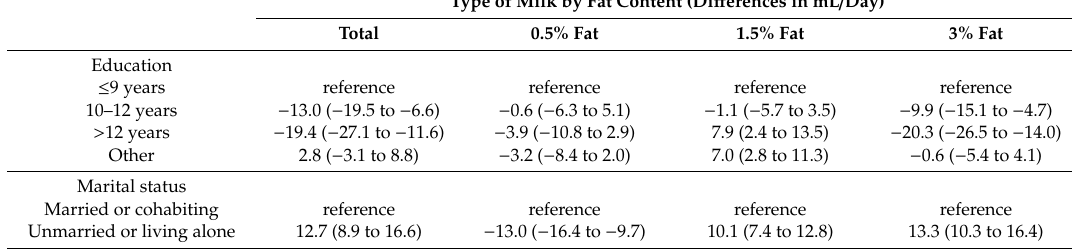
Table 3. Age-adjusted di ff erences in milk intake (mL / day), overall (column Total) and by fat content (columns 0.5% fat, 1.5% fat, and 3% fat, respectively), between categories of educational levels and marital status at baseline